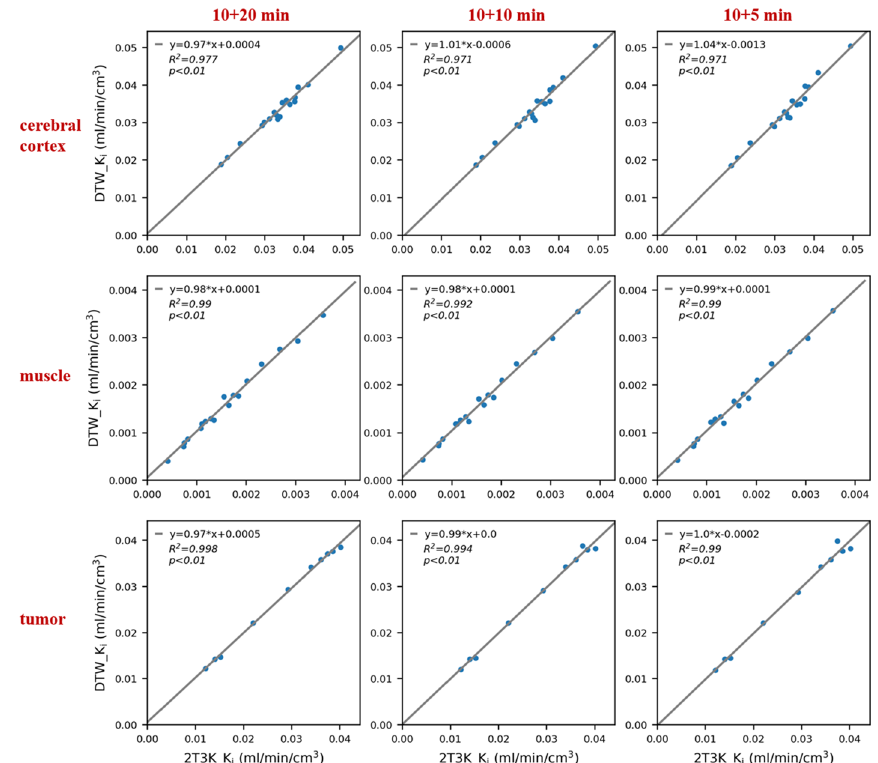
Fig. 4 Correlation analysis for K i derived from the DTW protocol with different scan durations. The ROIs were sampled in the cerebral cortex, muscle, and tumor lesion. The correlation plot for K 1 is shown in Additional file 1: Fig. S1. The associated Bland–Altman plots are shown in Additional file 1: Fig. S5